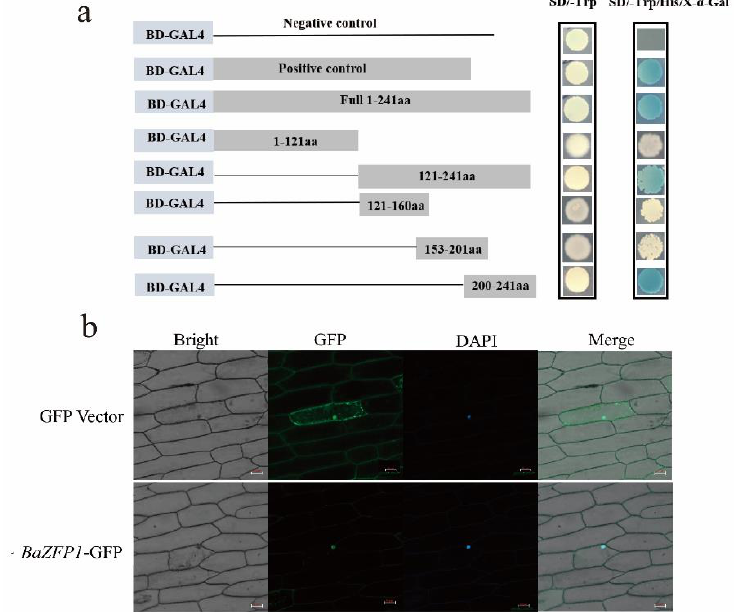
Figure 3. Transactivation activity and subcellular localization analyses of BaZFP1 . ( a ) Transactivation analyses of BaZFP1 . The fusion proteins of the GAL4 DNA-binding domain and BaZFP1 were expressed in the yeast strain Y2H Gold. Truncated BaZFP1 was fused with GAL4 BD, the vector pGBKT7 was used as the negative control, PGBKT7-53 was used as the positive control, and full- length BaZFP1 was fused with the GAL4 BD domain. ( b ) Subcellular localization analysis of BaZFP1 . Subcellular localization of BaZFP1 in onion epidermis cells. The onion epidermis was transiently infiltrated with A. tumefaciens EHA105 expressing GFP vector or BaZFP1 -GFP. Confocal images of the peeled epidermis were captured 72 h after inoculation at 488 nm by an LSM-800 laser scanning confocal microscope. Scale bars are 50 μm.